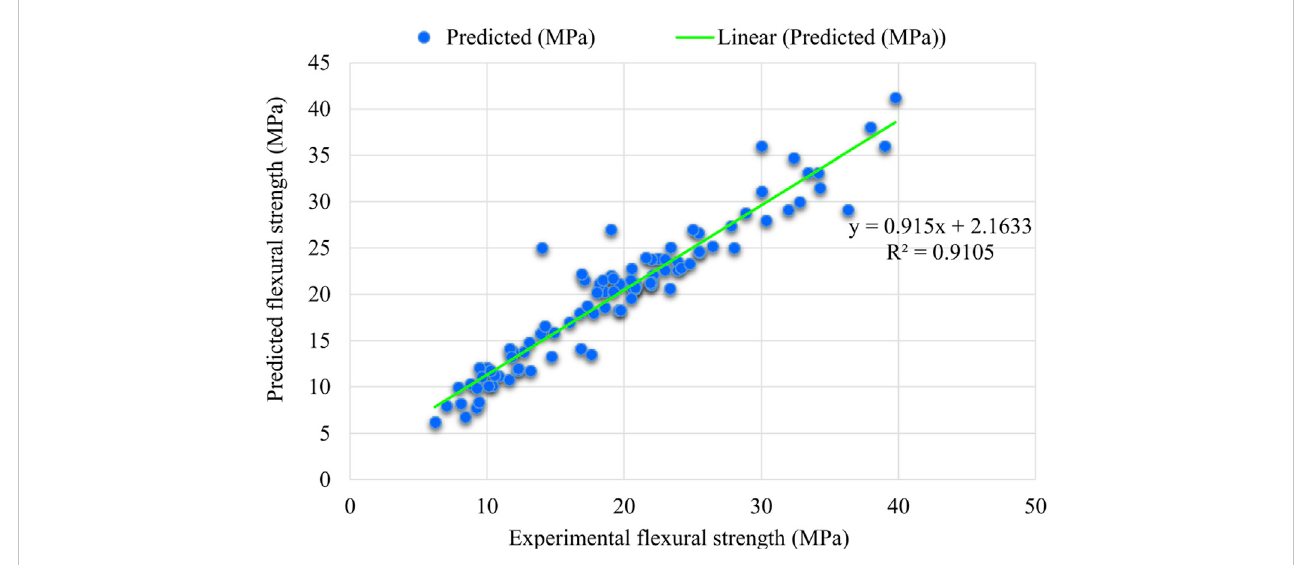
FIGURE 13 Experimental and predicted results for UHPC FS — GB model.